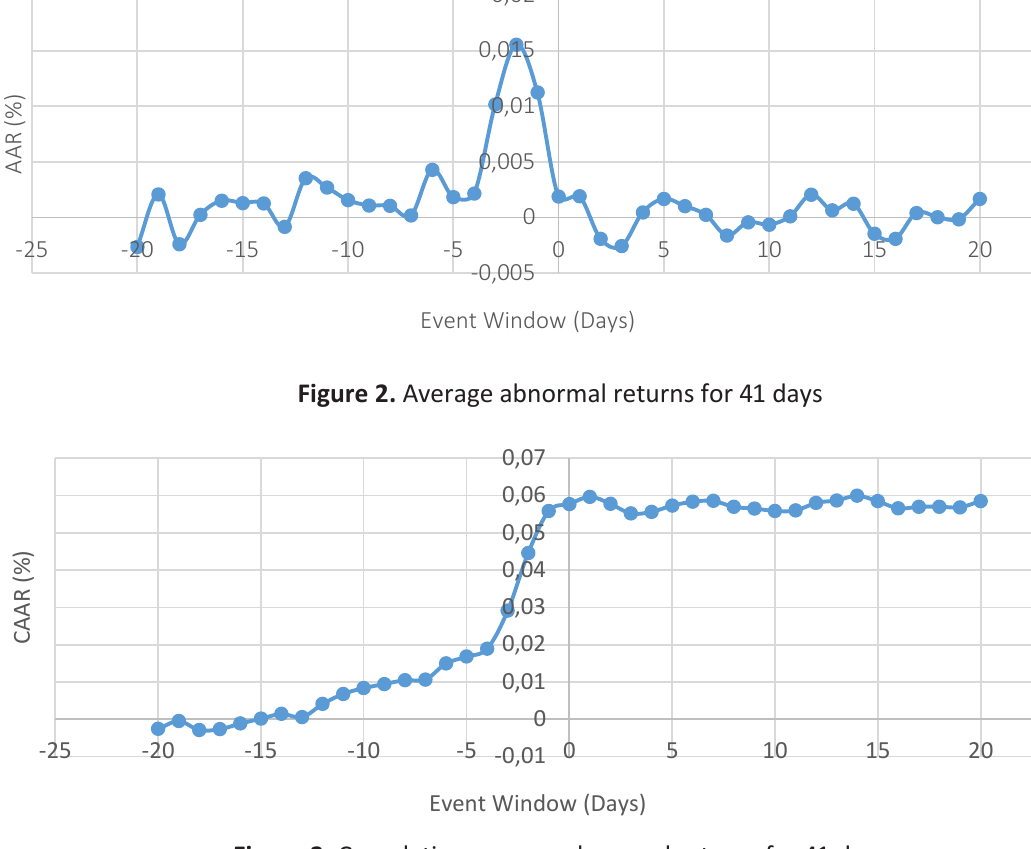
Figure 3. Cumulative average abnormal returns for 41